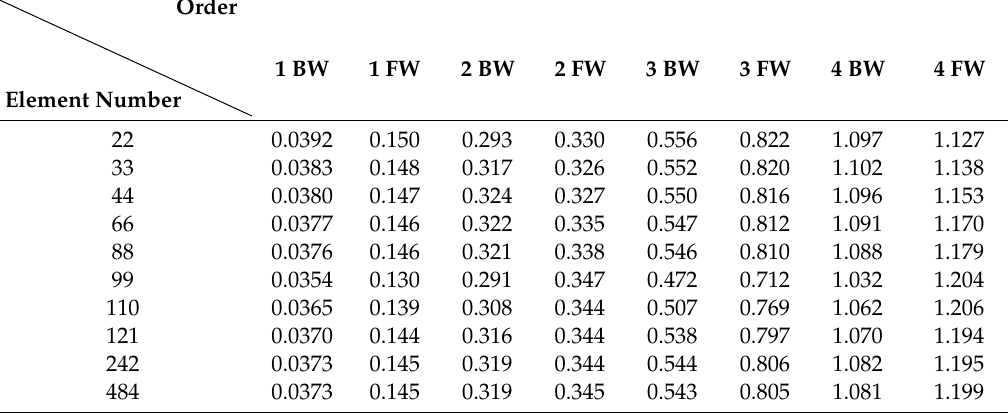
Table 10. Natural frequencies via spatial discretization ( h = 100